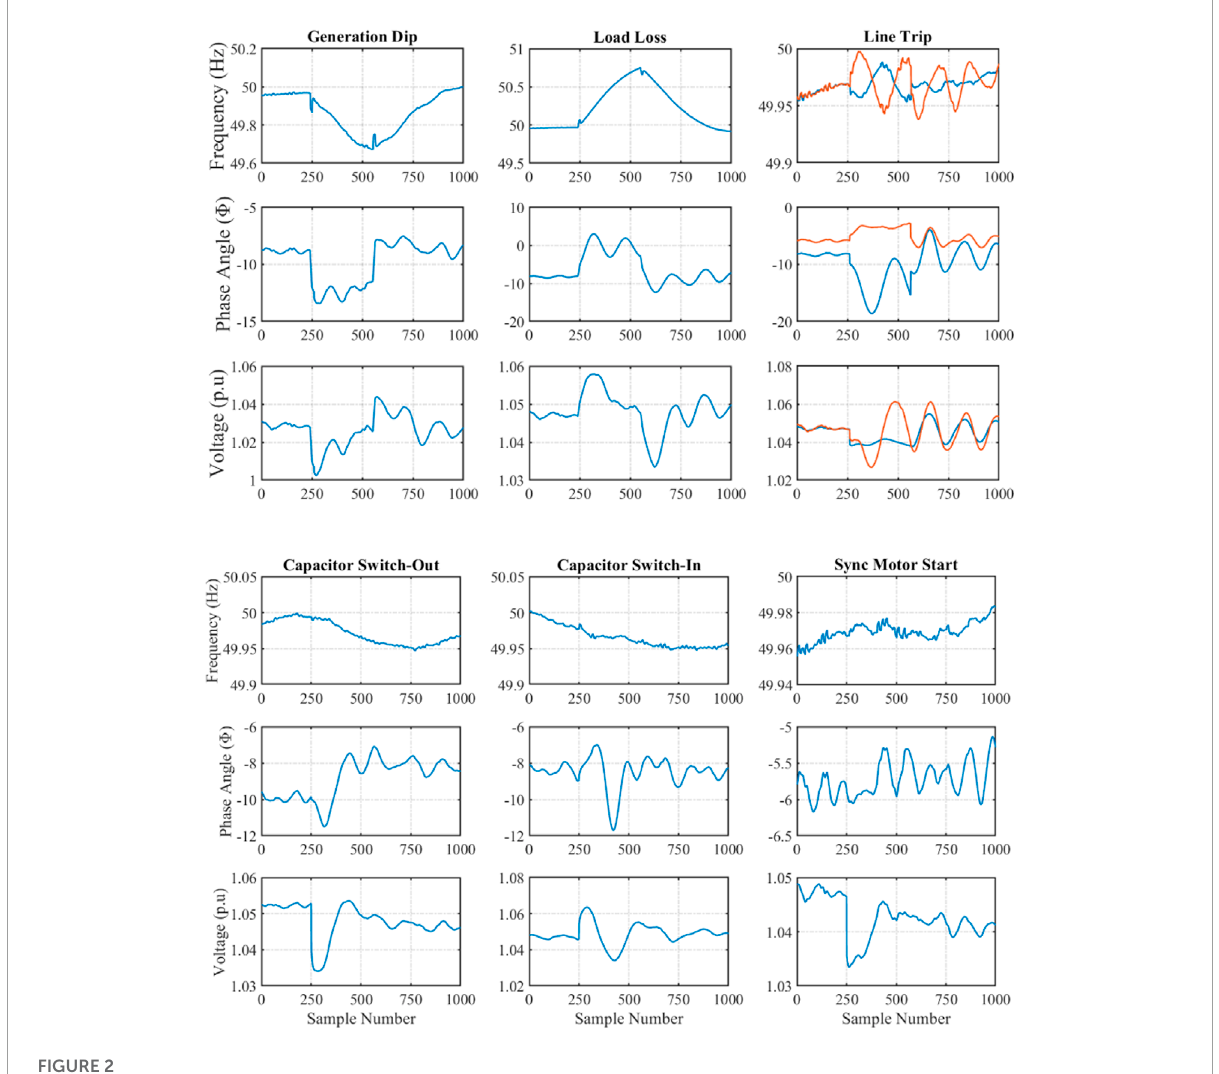
FIGURE 2 PMU recordings for different event